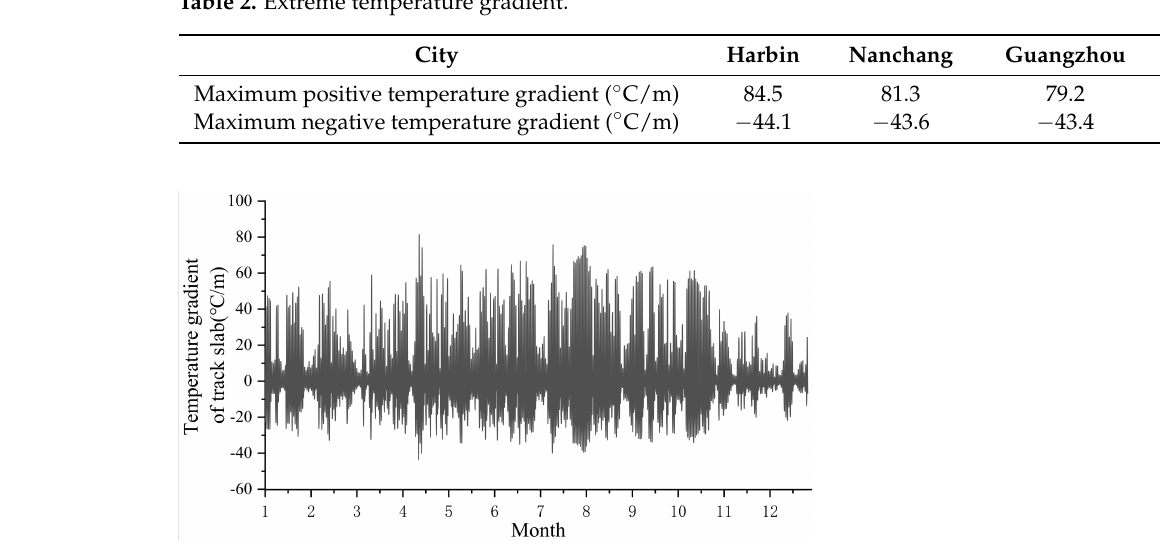
Figure 11. Annual temperature gradient of Nanchang.